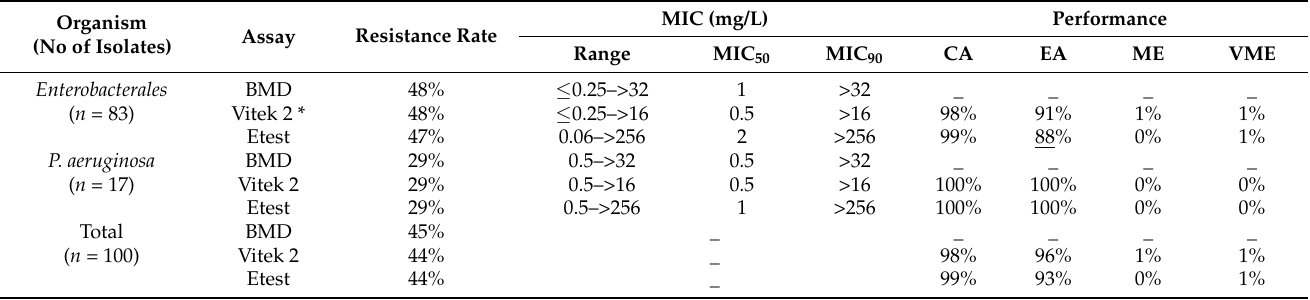
Table 3. Comparison of testing methods for the determination of susceptibility of Enterobacterales and P. aeruginosa isolates to ceftolozane/tazobactam according to the current EUCAST breakpoints